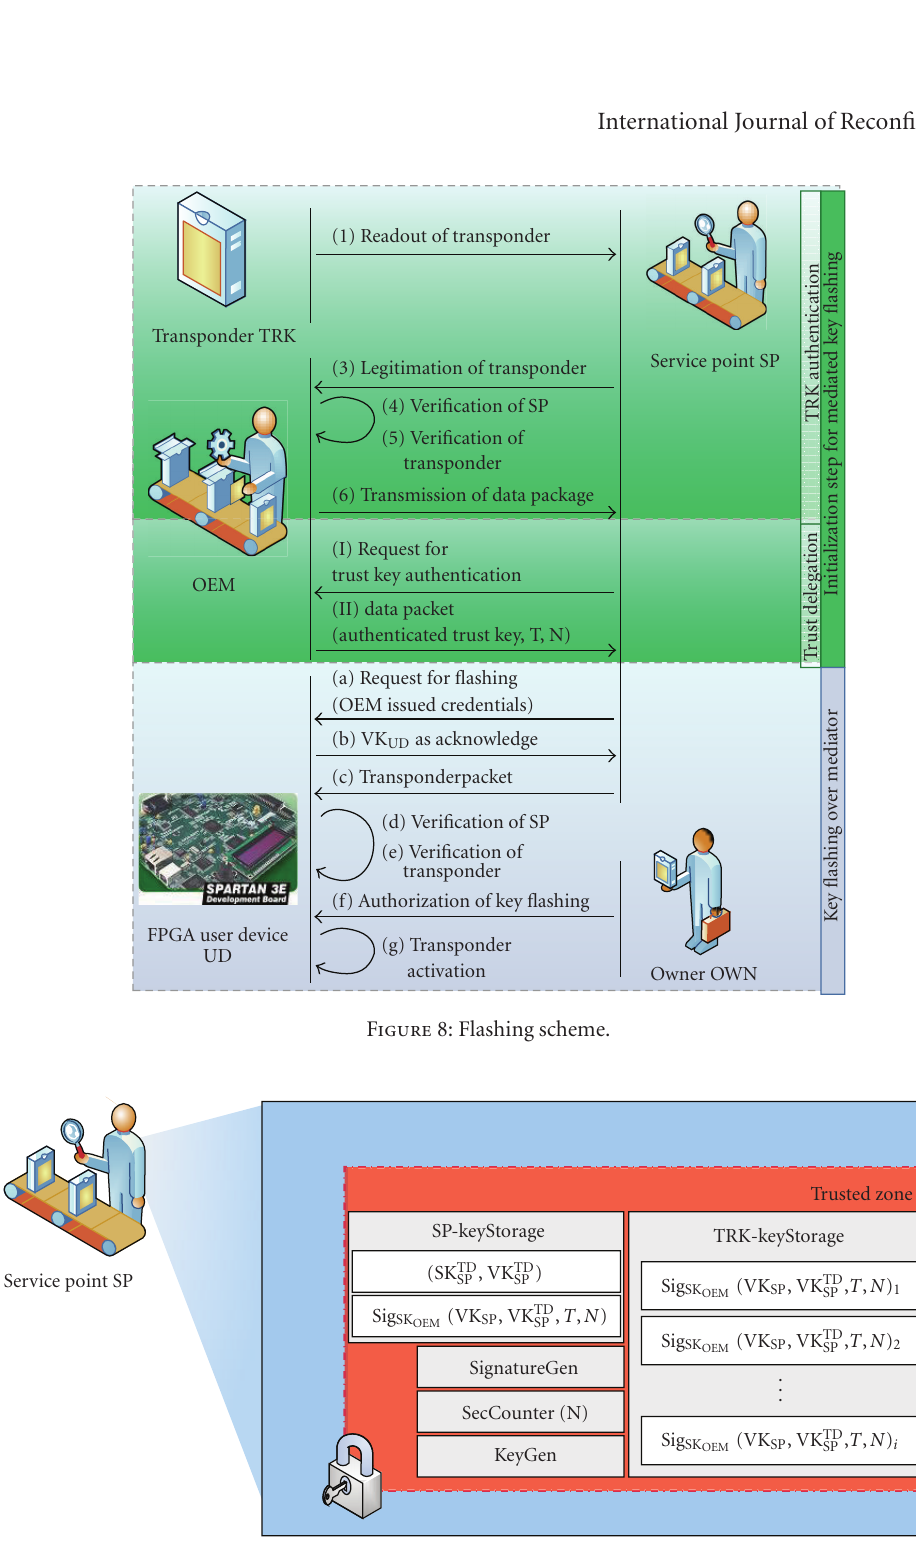
Figure 9: Service point as trusted